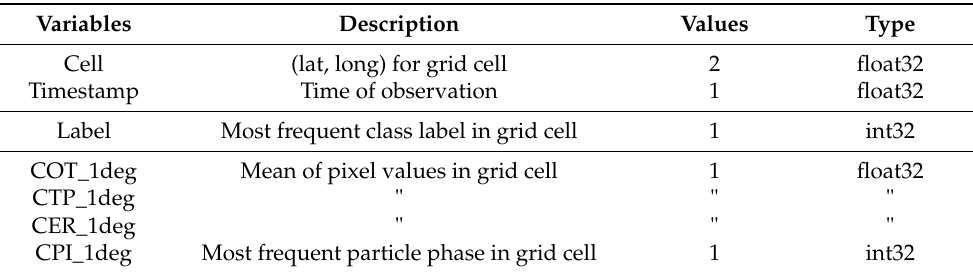
Table 3. AICCA information for each 1 ◦ × 1 ◦ grid cell: a cloud class label computed by RICC and diagnostic quantities obtained by aggregating MODIS data over all patch pixels for that grid cell. Variables Description Values Type Cell (lat, long) for grid cell 2 float32 Time of